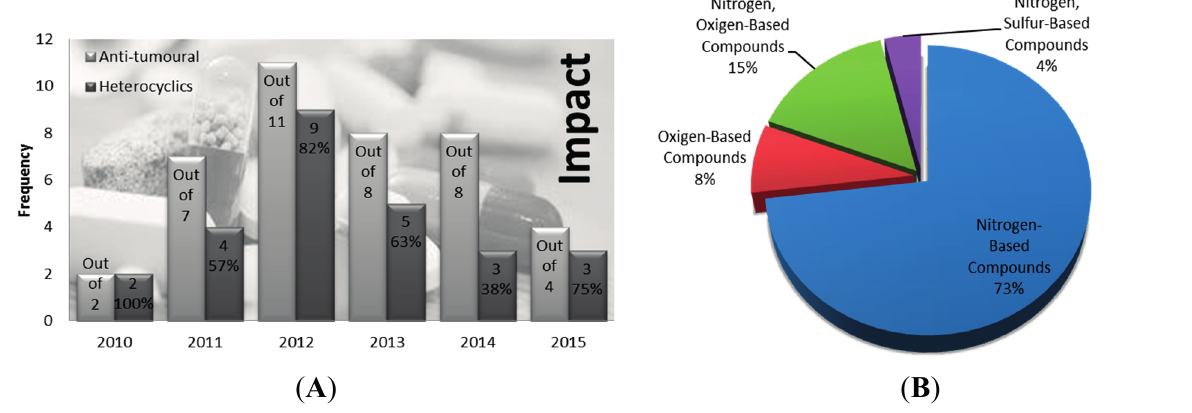
Figure 18. Impact of heterocyclic FDA approved anti-tumor drugs during the calendar years of 2010–2015 ( A ) and their respective discrimination by class and frequency ( B )